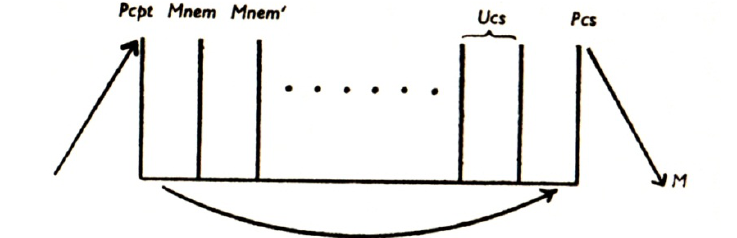
Figure 2. Freud’s second model of the mental apparatus. Pcpt (previously φ ) = Perceptual system; Mnem (previously ψ ) = Mnemic systems; Ucs = Unconscious system; Pcs = Preconscious system; M = Motor system [also known as Consciousness system, abbreviated Cs (previously ω )]. Reproduced from [5] with